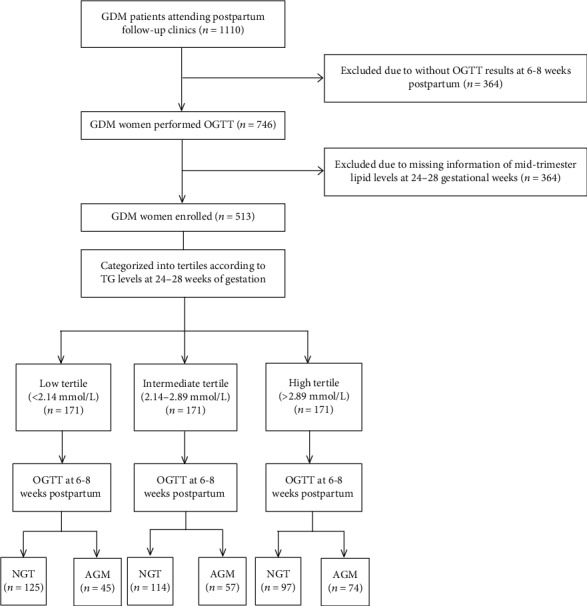
Subject screening and distribution. GDM: gestational diabetes mellitus; OGTT: oral glucose tolerance test; TG: triglyceride; NGT: normal glucose tolerance; AGM: abnormal glucose metabolism.